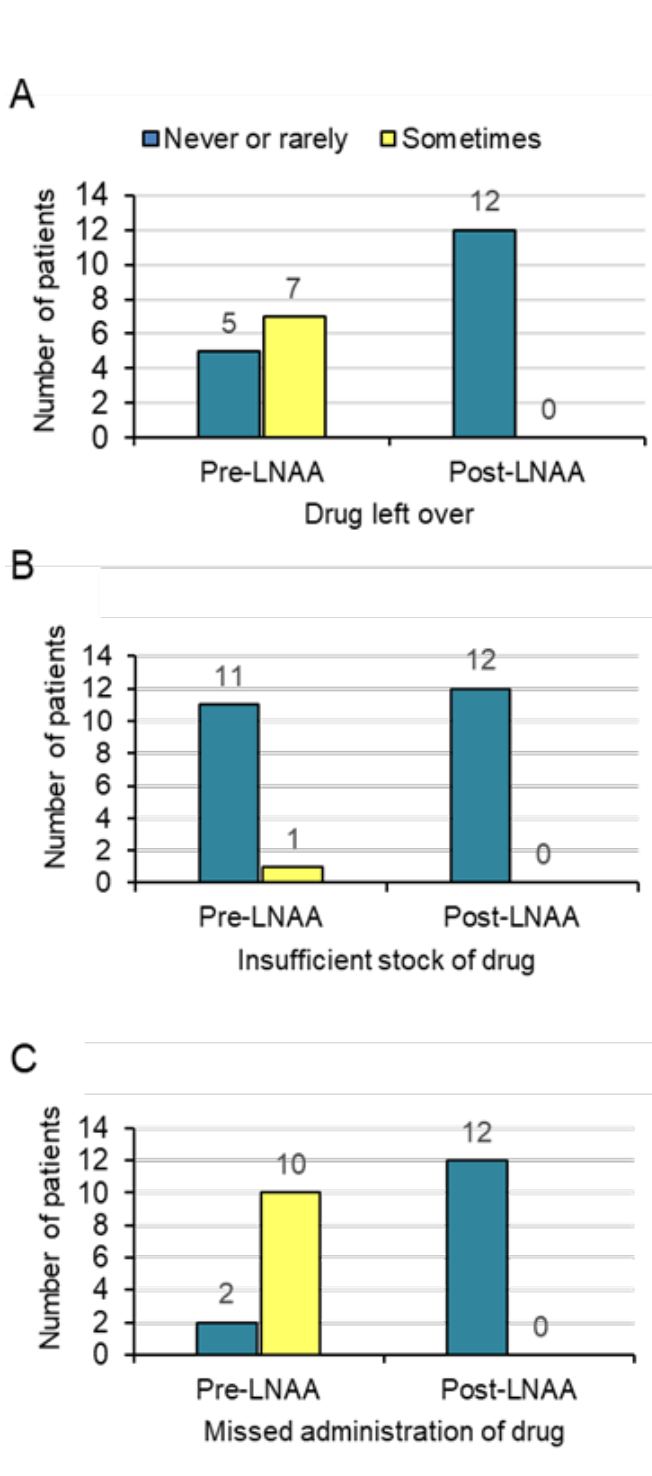
Figure 2. Frequency of non-adherence expressed by 3 questions relating to frequency over the past 4 weeks of A ) "Leftover drug," B ) "Insufficient stock of drug," and C ) "Missed administration of drug."